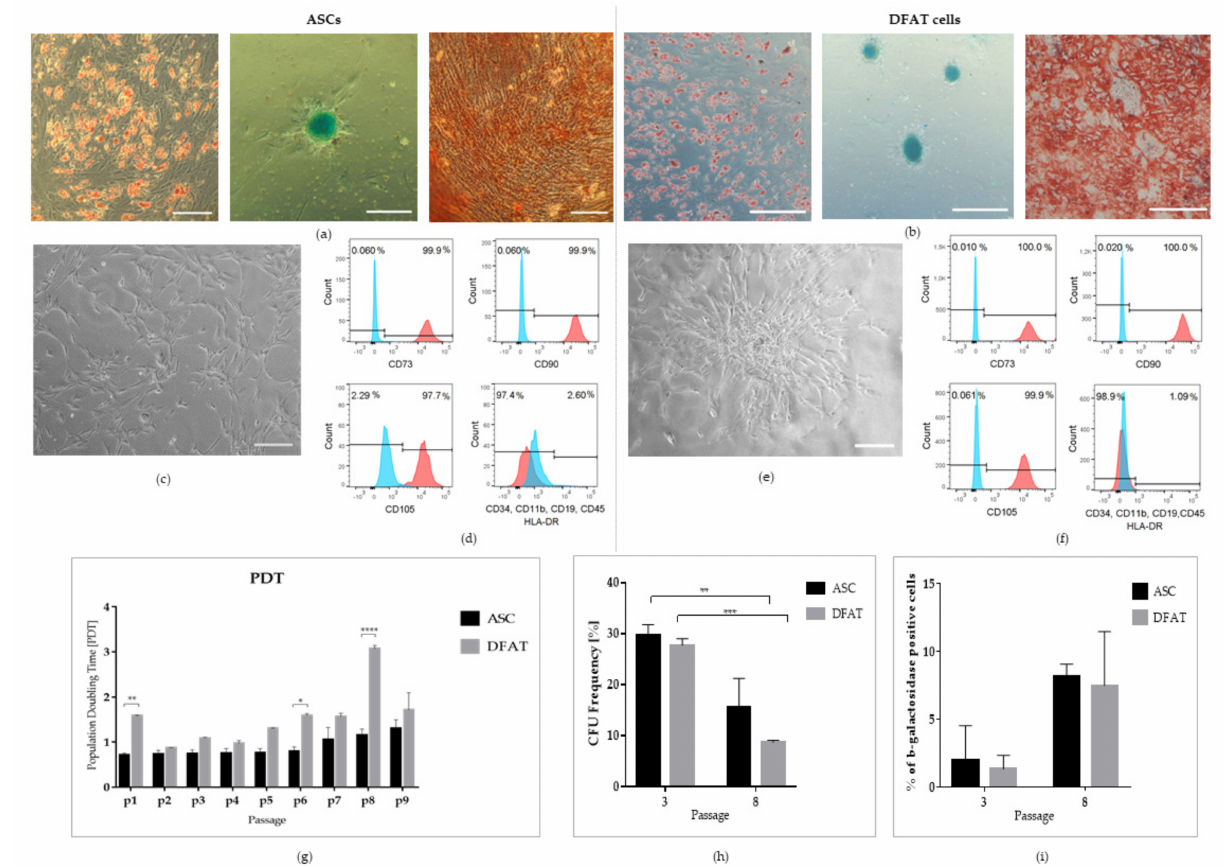
Figure 5. Multipotent properties of mesenchymal stem cells. ( a )ASCs’ Differentiation into adipocytes, chondrocytes and osteoblasts at 2nd passage of culture in 21% O 2 conditions; ( b )DFAT cells differentiation into adipocytes, chondrocytes and osteoblasts at 2nd passage of coulture, in 21% O 2 conditions; ( c ) Morphology of ASCs in 3rd day of culture, scale bar- 100 µ m; ( d ) Flow cytometry analysis of ASCs’mesenchymal markers presence: CD73, CD90, CD105 and absence: CD34, CD11b, CD19, CD45 and HLA-DR at 2nd passage of culture; ( e ) Morphology of DFAT cells in 3rd day of culture, scale bar—100 µ m; ( f ) Flow cytometry analysis of DFAT cells; mesenchymal markers presence: CD73, CD90, CD105 and absence: CD34, CD11b, CD19, CD45 and HLA-DR at 2nd passage of culture; ( g ) Population Doubling Time analysis from 1 to 9 passage; ( h ) Colony Formation Unit Frequency analysis at 3rd and 8th passage; ( i ) Senescence evaluation at 3rd and 8th passage. Cells cultured conditions: 5% O 2 , 5% CO 2 , 37 ◦ C. The results are presented as mean values of three experiments ± SEM. The differences were considered statistically significant when p -value < 0.05. Statistical significance level * for 0.01 < p < 0.05; ** for 0.001 < p < 0.01; *** for 0.0001 < p < 0.001; **** for p <